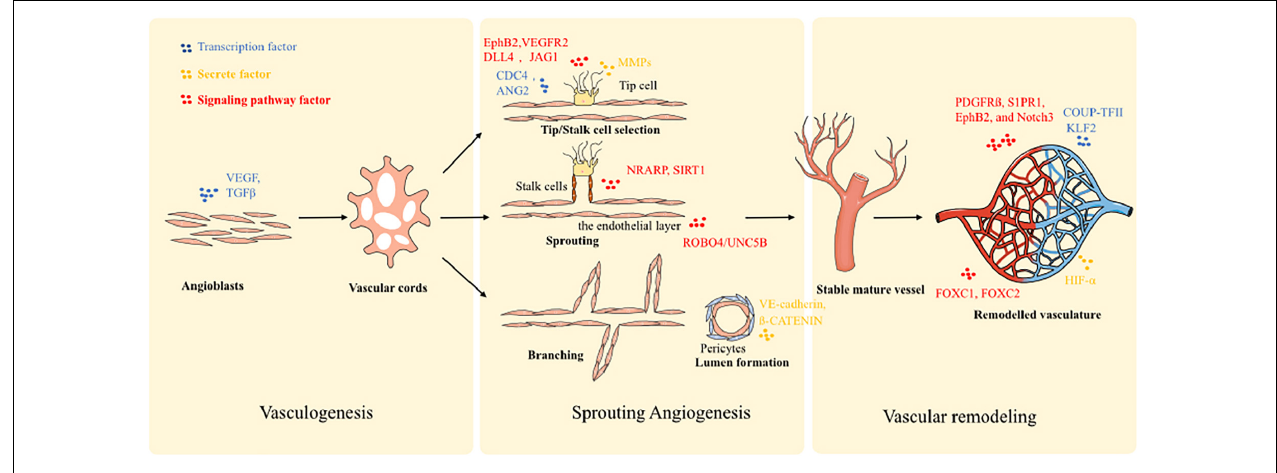
FIGURE 1 | The major molecular regulators in vasculogenesis, angiogenesis, and vascular